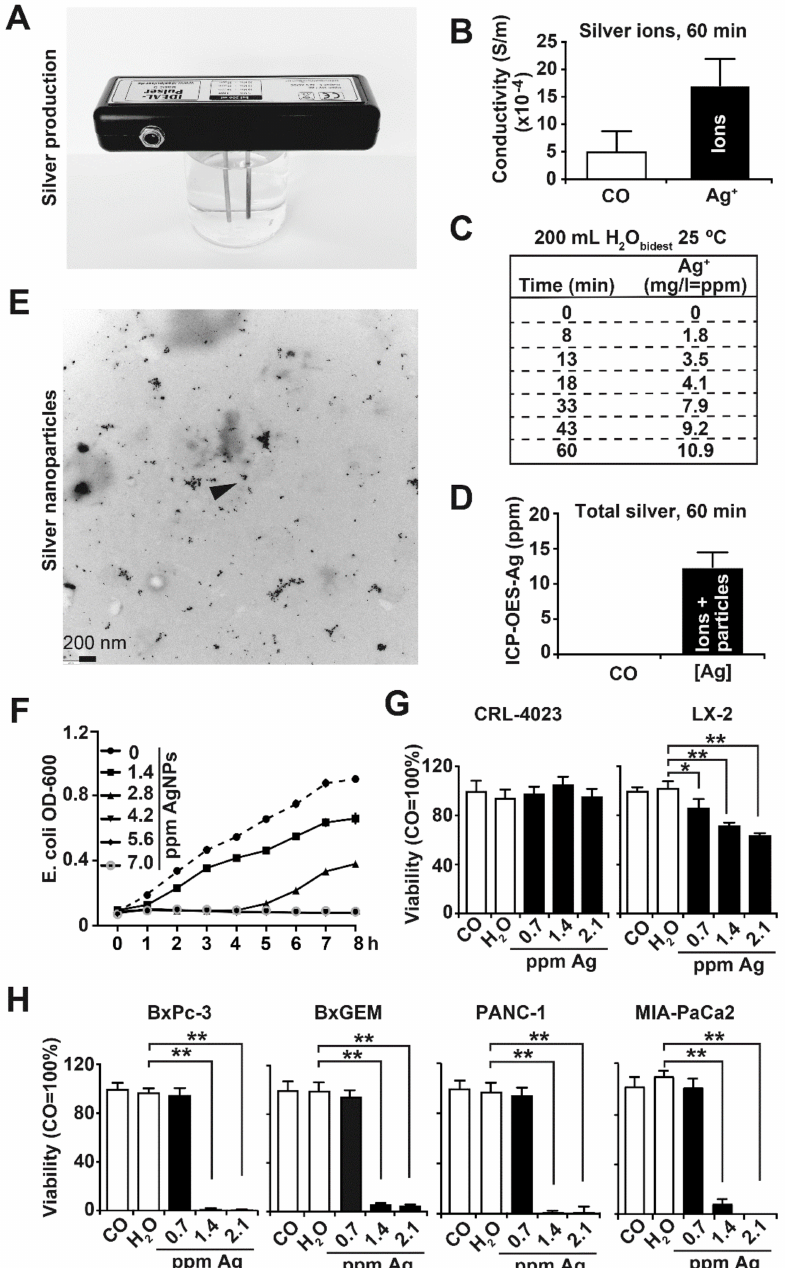
Figure 1. Generation of AgNPs and characterization. ( A ) Nanosilver particles were produced by pulsing 200 mL boiled H 2 O bidest at 25 ◦ C with the IDEAL-Pulser Basic S silver generator, and a representative picture is shown. ( B ) The conductivity of H 2 O bidest (CO) and a AgNP (Ag) solution pulsed for 60 min was analyzed by a network analyzer, and the presence of conductive silver anions (Ag + ) is given as Siemens per meter (S/m). ( C ) The concentration of Ag + ions before and after pulsing for 8, 13, 18, 33, 43 and 60 min was determined by conductivity measurement and calculation. The values are provided as mg/L, which corresponds to parts per million (ppm). ( D ) The concentration of total silver, consisting of silver particles and Ag + ions, was determined by plasma optical emission spectrometry (ICP-OES) in at least three independent experiments 60 min after pulsing. H 2 O bidest served as the control (CO). ( E ) A 14 ppm AgNP solution was examined by TEM. The black dots indicate AgNPs, and the arrow points to a silver particle with a typical size of 9 nm. The visible larger clumps mainly result from aggregated particles. The scale bar indicates 200 nm. ( F ) E. coli OP50 bacteria were pipetted into single wells of a 96-well plate containing AgNPs at final concentrations